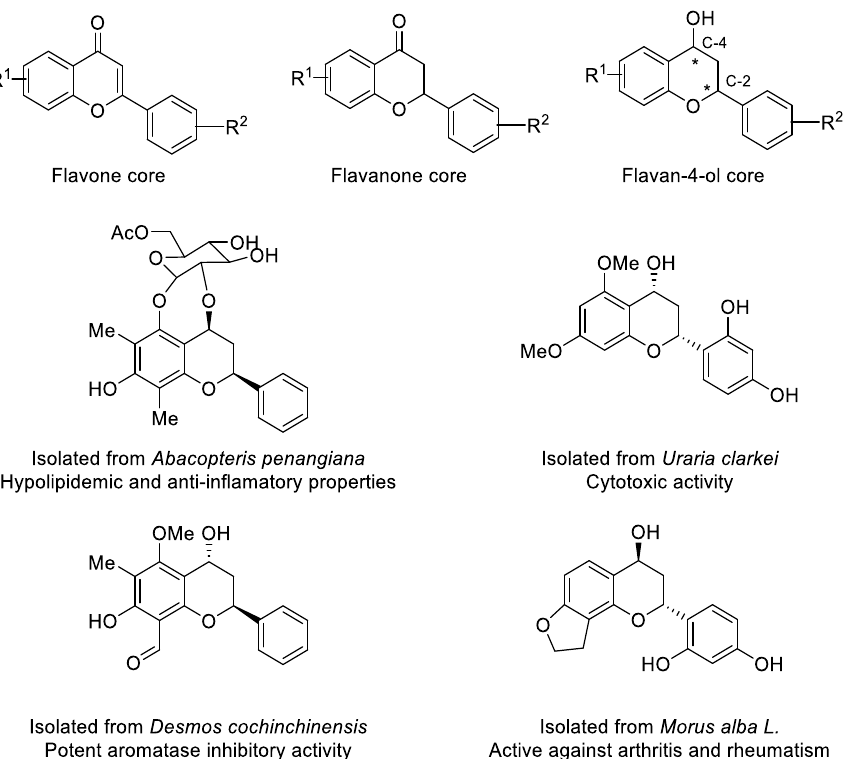
Figure 1. General structure of flavones, flavanones and flavan-4-ols. Above appear the structures of naturally occurring flavan-4-ols including examples of all four different absolute configurations at the C-2 and C-4 positions.